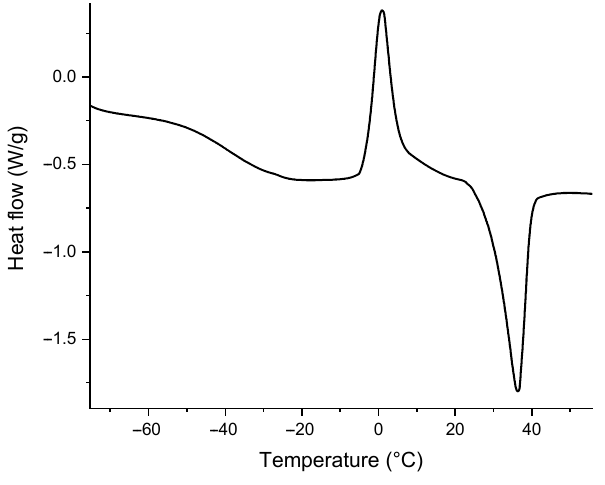
Figure 3. DSC trace of P(PEG350) 3 .